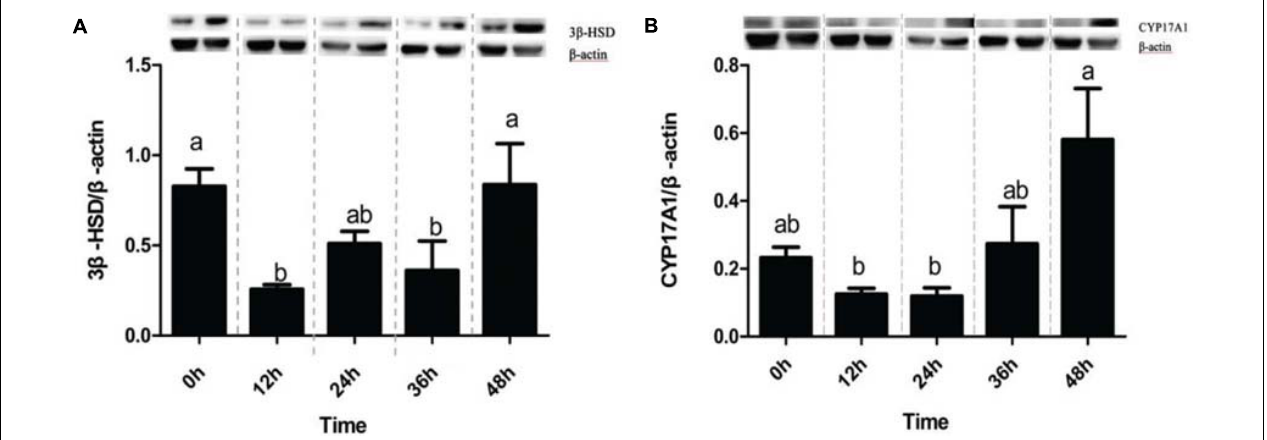
FIGURE 2 | Expression profiles of tested proteins in Channel Catfish exposed to ammonia nitrogen stress. Western blot analysis of CYP17A1 and 3 β -HSD in the kidney was at 0 h before ammonia nitrogen stress and 12, 24, 36, and 48 h after ammonia nitrogen stress. The protein relative expression levels of CYP17A1 and 3 β -HSD were normalized to β -actin (A,B) . Values are represented as mean ± SE ( n = 3). Mean values with different letters (a–c) were significantly different ( P < 0.05).